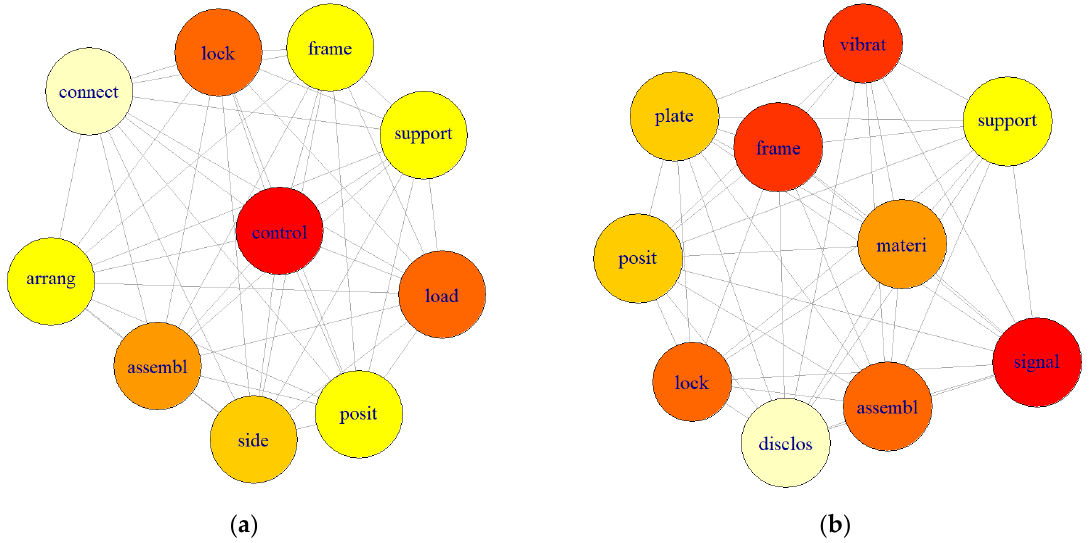
Figure 8. Results of the keyword network analysis: ( a ) 9th patent vacuum and ( b ) 10th patent vacuum.